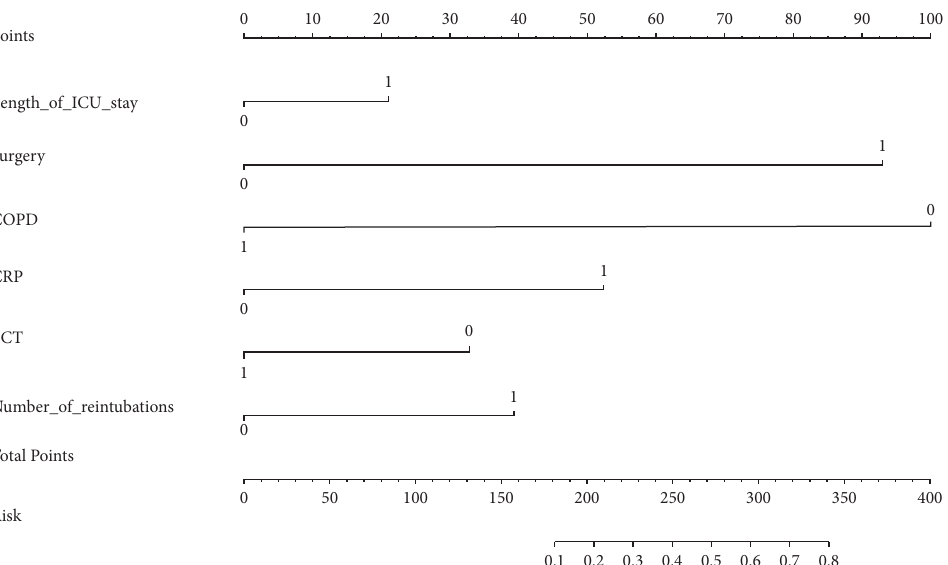
Figure 1: VAP risk prediction nomogram of elderly ICU patients on mechanical ventilation.